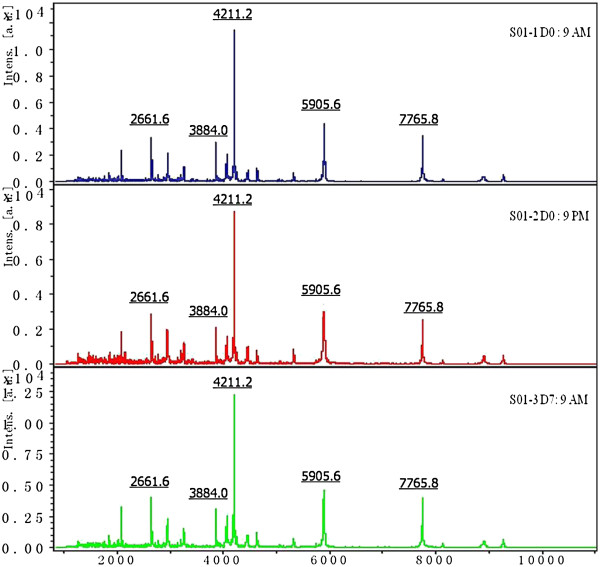
The triplicate serum mass spectra of a representative sample at various time points under the standard conditions. X-axis represents mass to charge ratio, and Y-axis represents the intensity (expression levels).